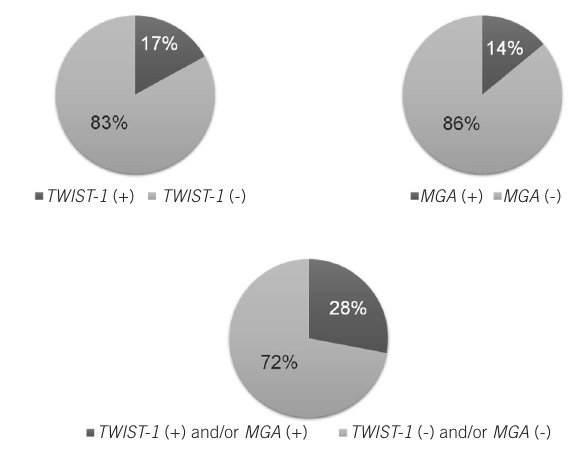
TWIST-1 (+) and/or MGA (+) TWIST-1 (-) and/or MGA (-) Analysis of the CTC FIGURE 1 – Pie charts showing percentages of patients with CTCs detected by analyses of the expression of TWIST-1 , MGA and the combination of expression of both genes CTCs: circulating tumor cells.